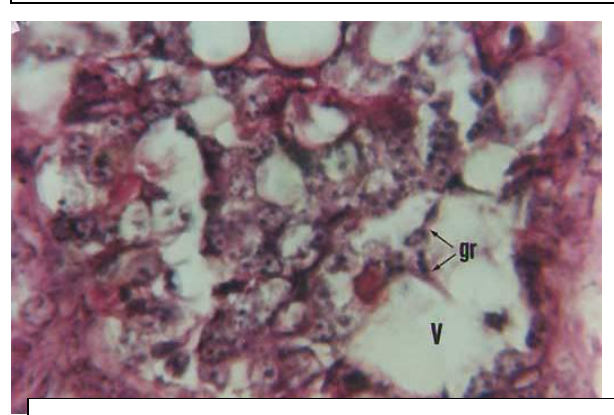
(Fig.18): Photo m icrosco pie illustrates that vesicular lumens (V) have secretory . granular (PAS stain, 100 X)